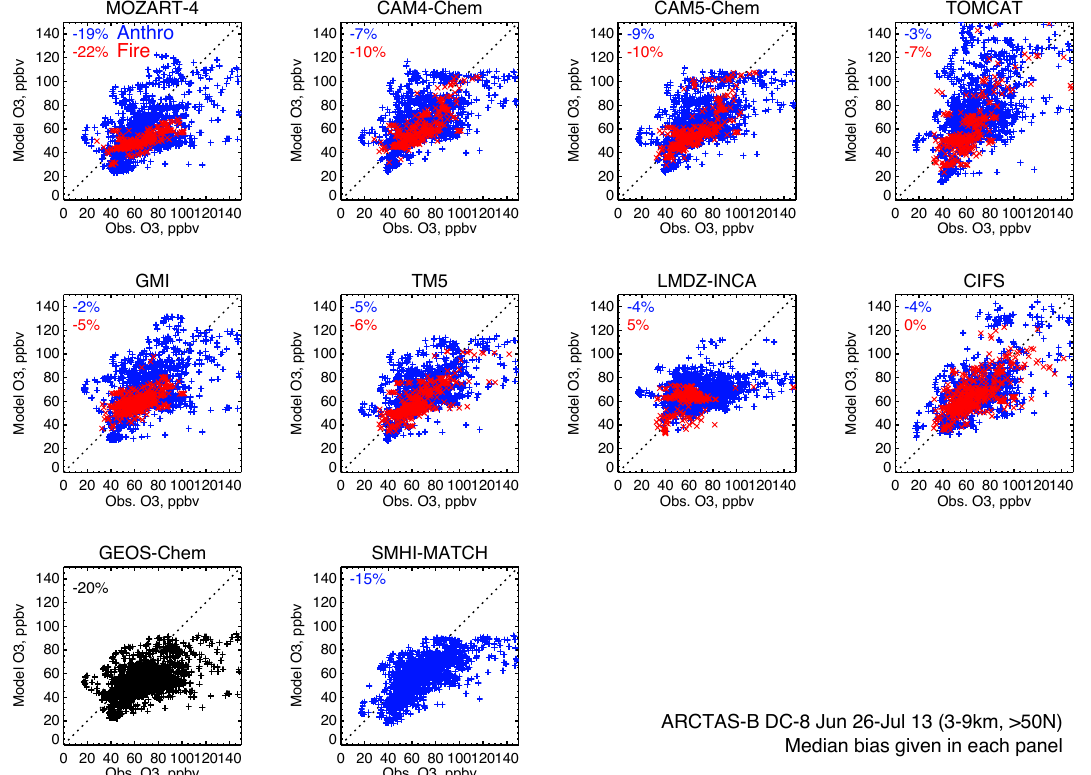
Figure 1. POLMIP model ozone interpolated to selected ARCTAS-B DC8 flight tracks north of 50 ◦ N, and between 3–9km altitude plotted as a function of the DC8-observed concentrations. Blue and red colours show model points which are dominated by anthropogenic and biomass burning emissions respectively, as diagnosed by 25-day fixed-lifetime CO tracers simulated by the models (see text for details). Mean fractional model biases (%) in anthropogenic- and fire-dominated air are shown in blue and red text respectively. The GEOS-Chem model did not simulate 25-day fixed-lifetime